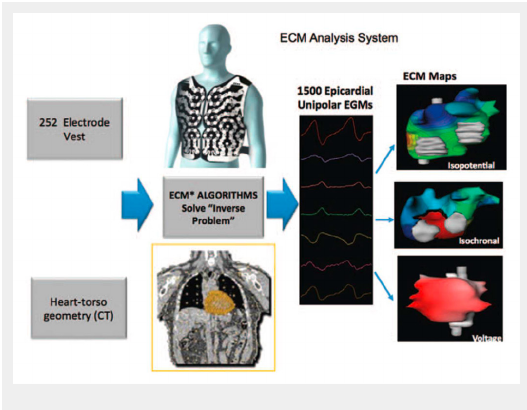
Overview of the components of the ECG mapping system. The key component of the mapping system is the 252 electrodes that are embedded in a vest that can easily be placed on a patient torso. With the vest on, a computed tomographic (CT) scan of the chest obtains the precise anatomical relation between the 252 electrodes on the vest and the epicardial surface of the heart.